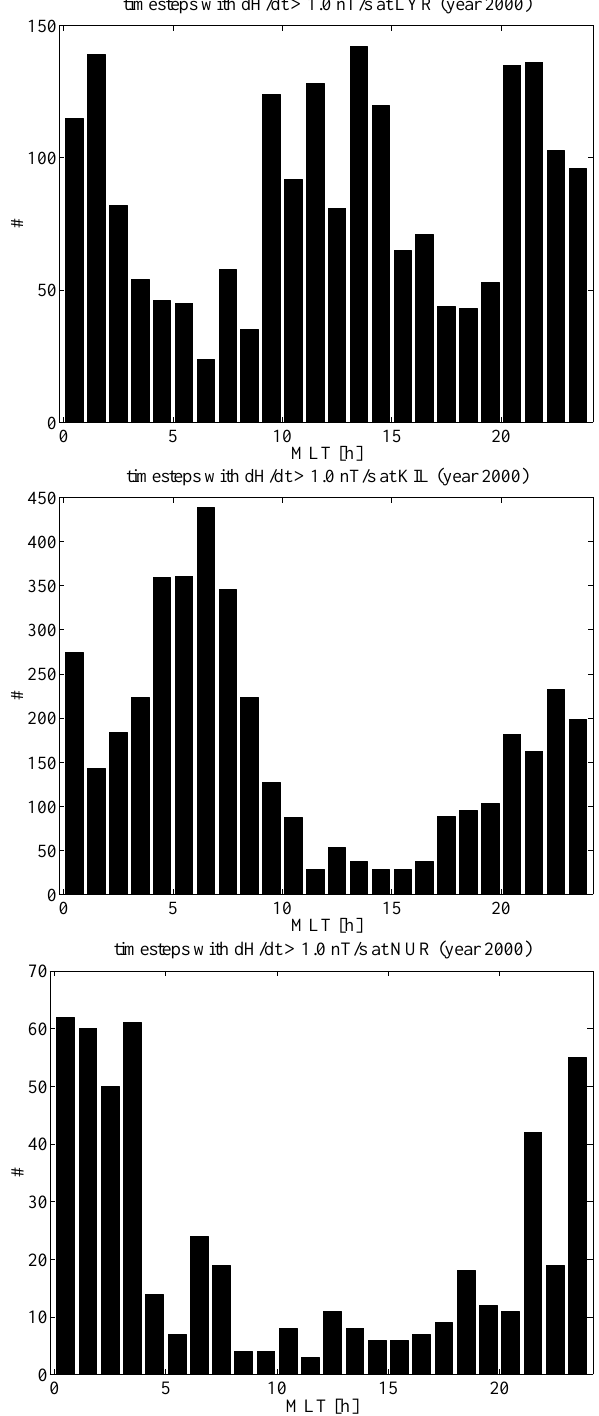
Fig. 8. Diurnal variation of the number of timesteps in 2000 when | d H /dt | exceeded 1nT/s at three IMAGE magnetometer stations (one-minute data). LYR is located in the cusp/polar cap, KIL in the auroral region, and NUR in the subauroral region. The magnetic local time (MLT) is given in the solar magnetic coordinate system (roughly, MLT = UT + 3